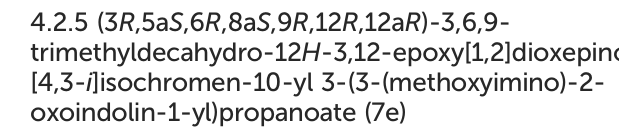
TABLE 4 Pharmacokinetic properties of hybrid 7d in